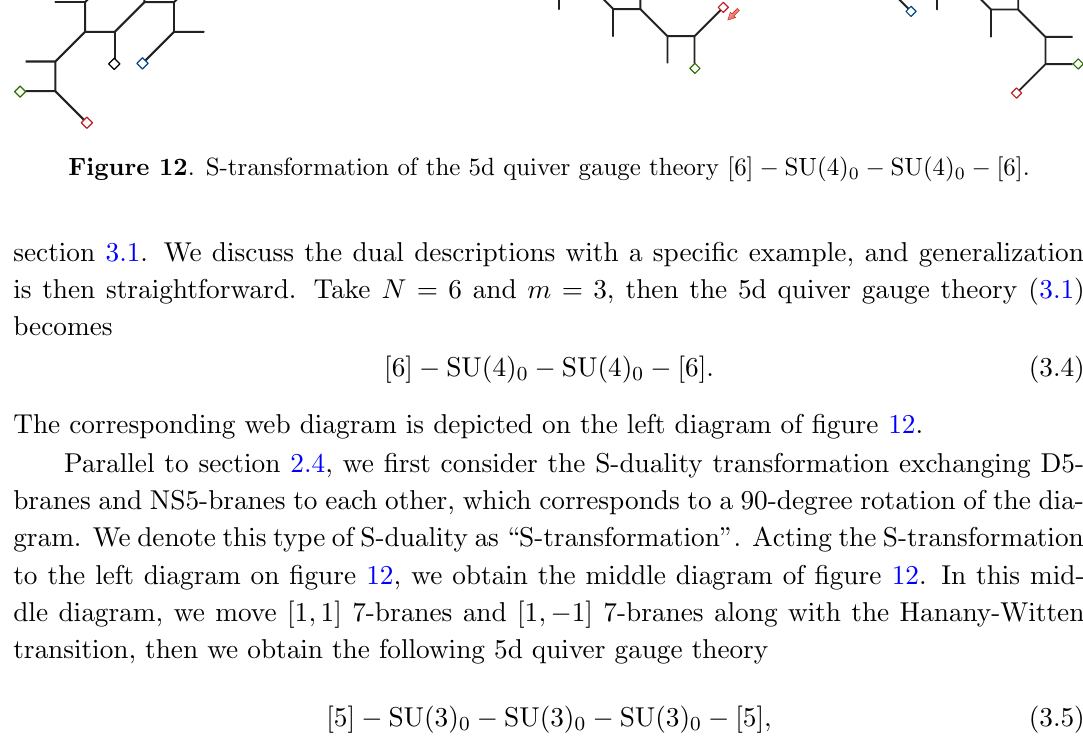
Figure 12 . S-transformation of the 5d quiver gauge theory [6]